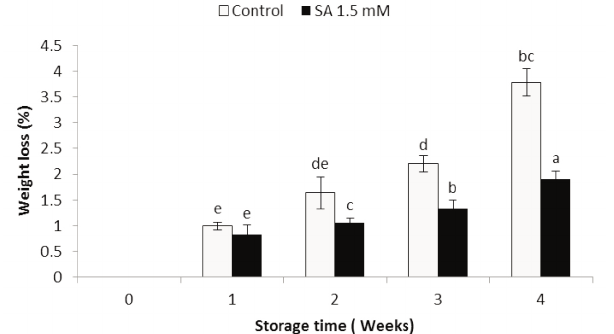
Fig. 1 - Weight loss of peach fruits treated with preharvest SA at 1.5 mM stored at 1 ± 0.5°C for up to 28 days. Data shown are mean ± standard deviation of three replicate (n =